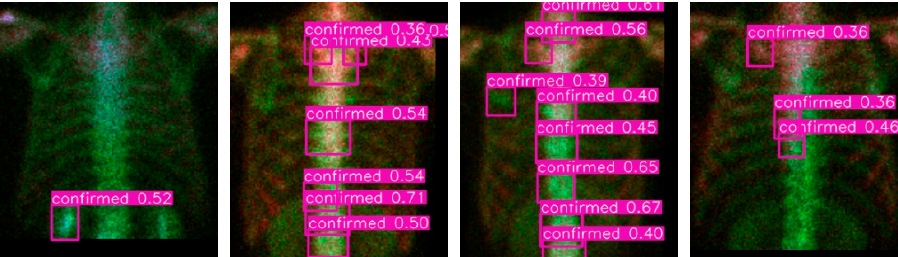
Figure 9. Qualitative results of the negative mining process on the breast cancer patients without metastases on the chest.